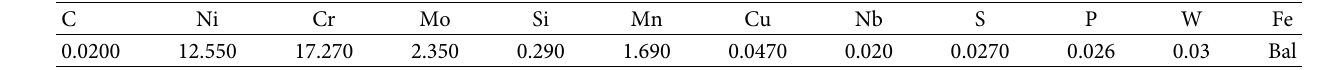
Table 1: Substrate material chemical composition in wt %.